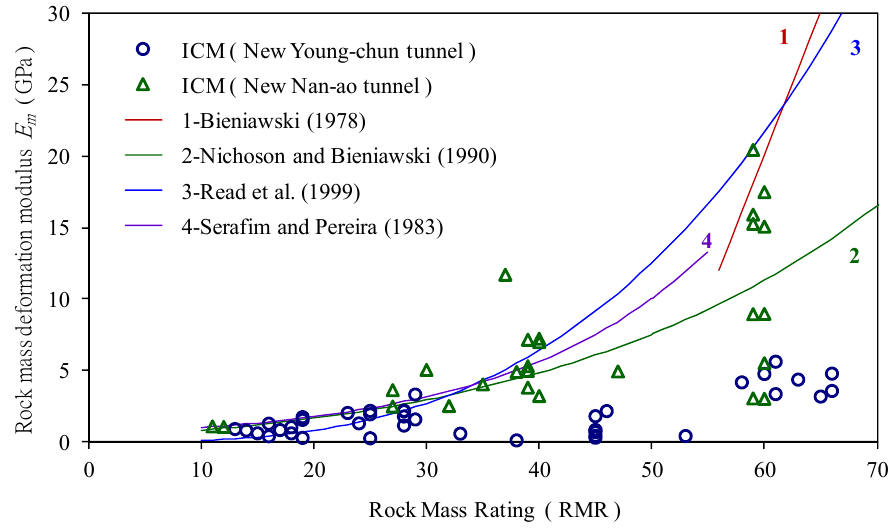
Figure 11. Correlation between the modulus of rock mass predicted by the inverse analysis (ICM) and the rock mass rating (RMR) of the presentation of the two railway tunnels.